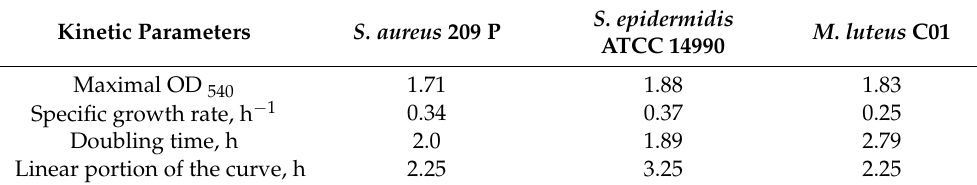
Table 2. Kinetic parameters of bacterial growth in BHI.